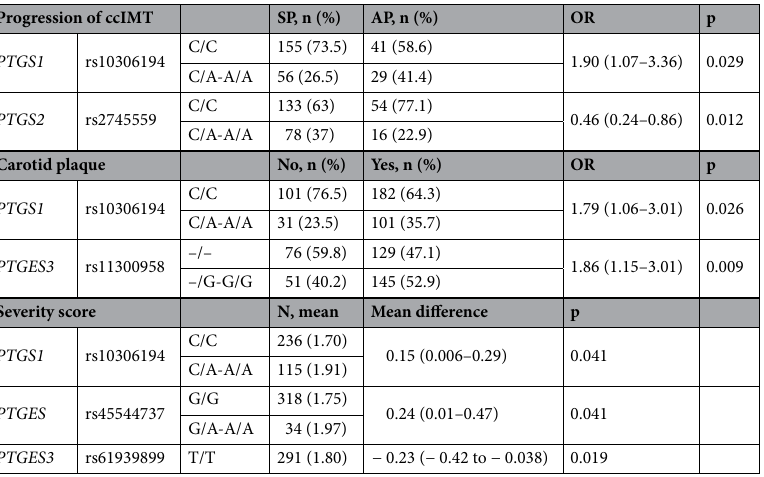
Table 4. Adjusted genetic association analysis with atherosclerosis measurements in patients with nephrosclerosis. SP slow progression, AP accelerated progression. These parameters have previously been analyzed in the same patients regarding their association with other gene sets in previous studies by our group 11,12